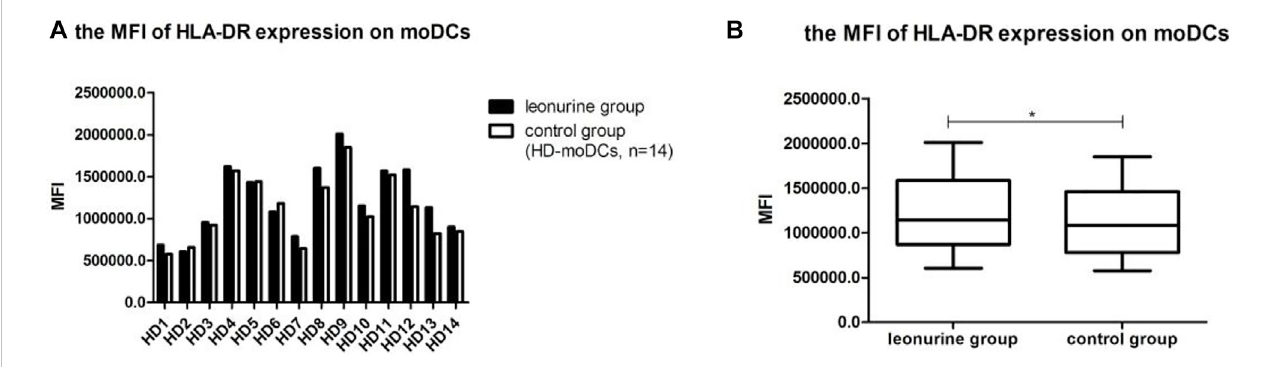
FIGURE 7 TheMFIofHLA-DRexpressiononmoDCsbetweentheleonurinegroupandthecontrolgroup(HD-moDCs, n =14). (A) ThegraphshowstheMFIofHLA- DR expression on moDCs betweenthe leonurine group and thecontrol group for each HD. (B) The boxplot shows that when moDCs derived from all 14 HDs were analyzed together, the MFI of HLA-DR expression on moDCs was signi fi cantly higher in the leonurine group than in the control group (12.21 × 10 5 ± 4.20 × 10 5 vs. 11.11 × 10 5 ± 3.94×10 5 , p = 0.013, paired-sample t